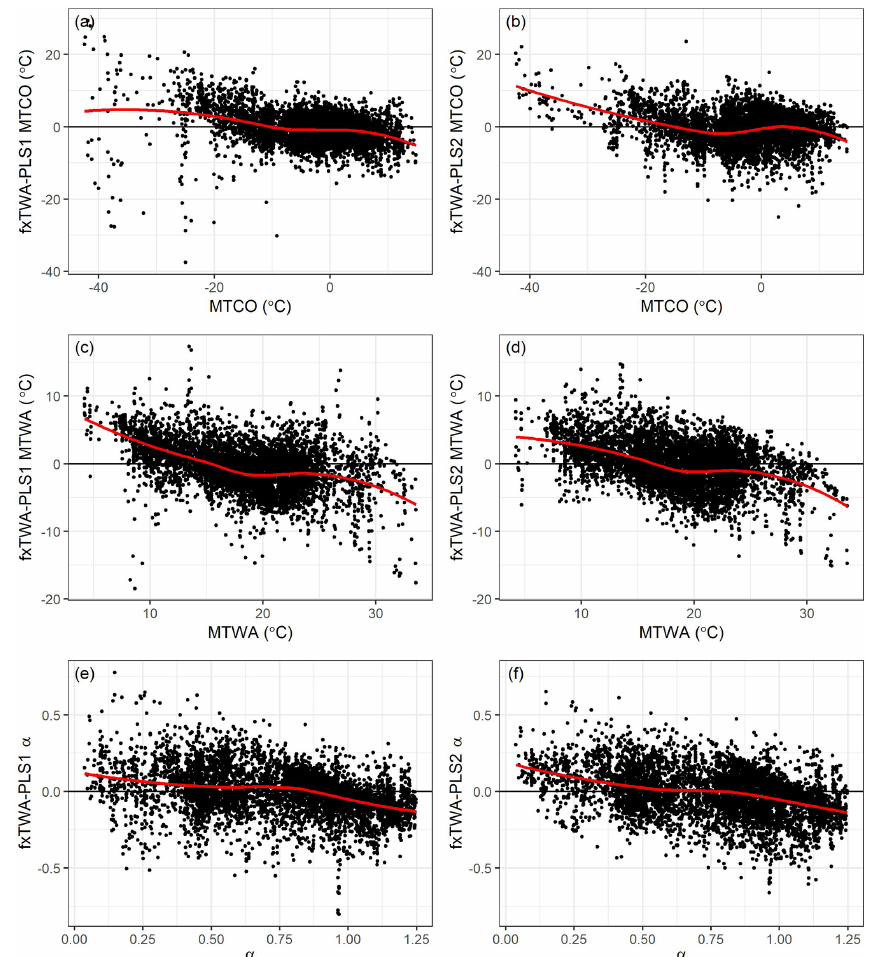
Figure A2. Residual using the last significant number of components for mean temperature of the coldest month (MTCO), mean temperature of the warmest month (MTWA) and plant-available moisture ( α ). The left column ( a , c and e ) shows the previous version (fxTWA-PLS1) and the right column ( b , d and f ) shows the modified version (fxTWA-PLS2) of fxTWA-PLS. The zero line is shown in black; the locally estimated scatterplot smoothing is shown in red to show the degree of local